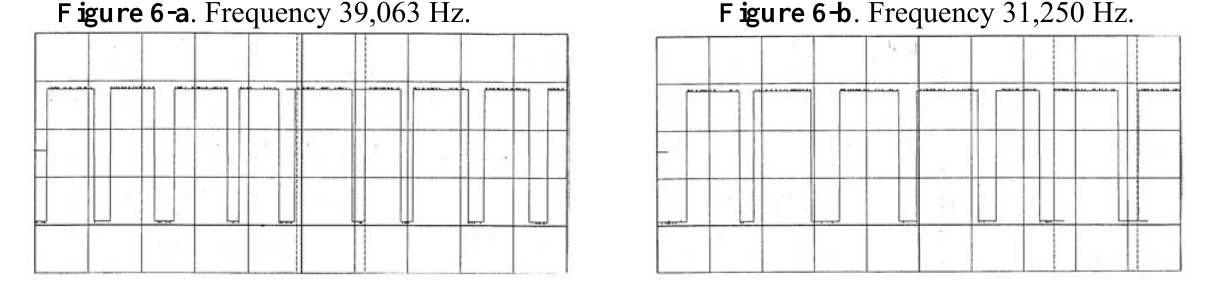
Figure 6-b . Frequency 31,250